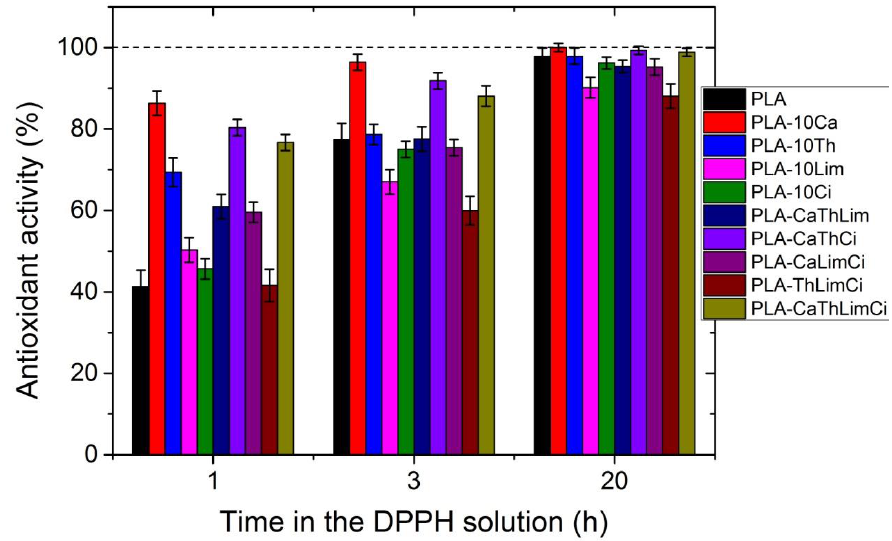
Figure 17. Antioxidant activity of all composites at several timepoints incubated in the DPPH solution.